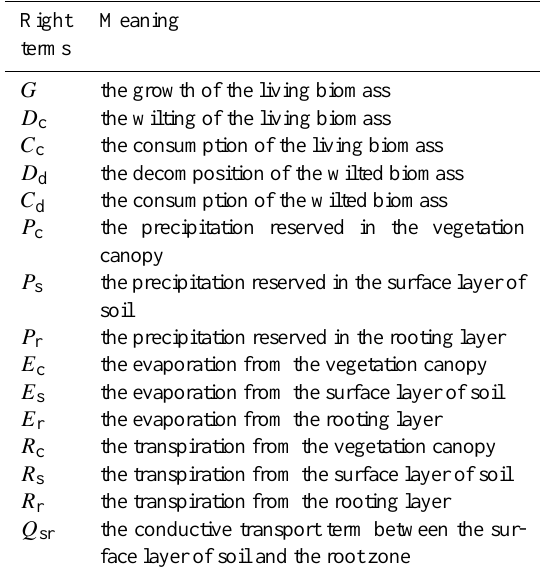
Table A1. The right terms in the five-variable ecosystem model. Right Meaning terms G the growth of the living biomass D c the wilting of the living biomass C c the consumption of the living biomass D d C